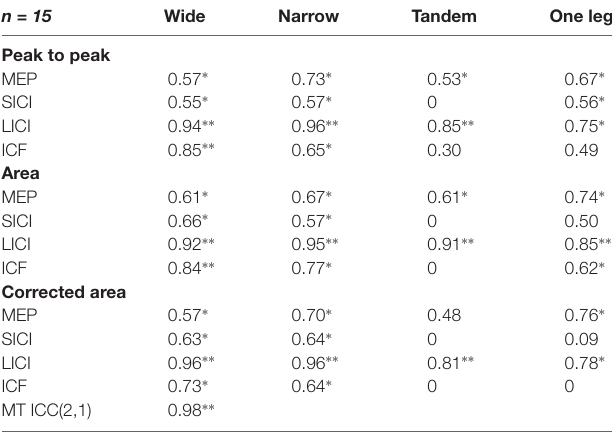
TABLE 1 | Intraclass correlation coefficients (2,k) for transcranial magnetic stimulation (TMS) outcomes. n = 15